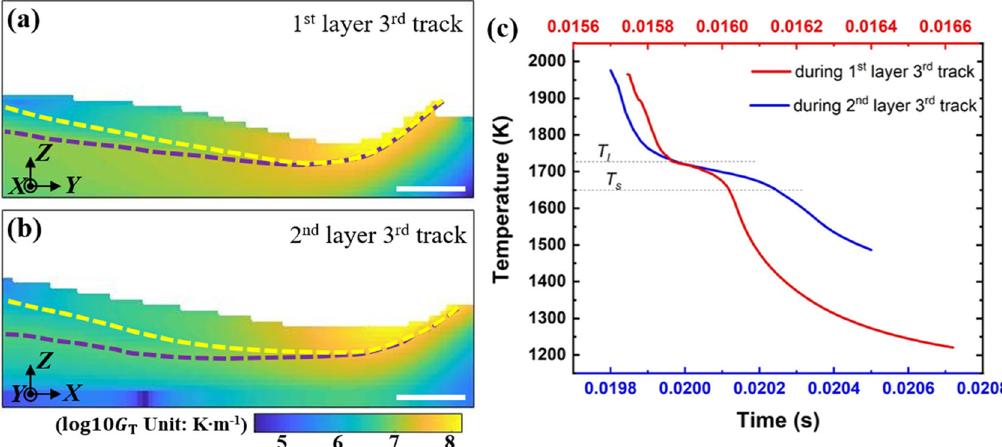
Fig. 8 Analysis on the temperature fi eld. Temperature gradient at the longitudinal section of the molten pool in a 1 st layer 3 rd track and b 2 nd layer 3 rd track, with yellow/purple dashed line indicating the contour of liquidus/solidus temperature. The region between the two curves is named mushy zone. The color bar represents the value of log10 G T . c Temperature histories of the 1 st layer 3 rd track and 2 nd layer 3 rd track. Scale bar, 50 µm in a , b